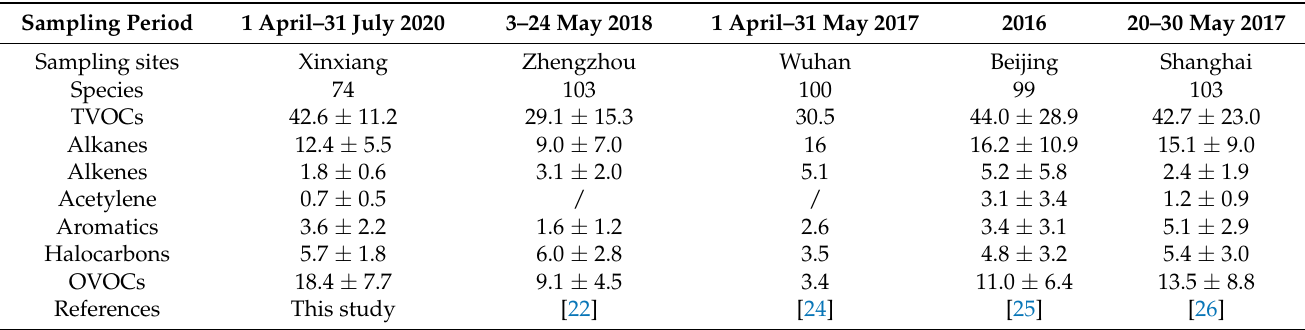
Table 1. Concentrations of VOCs and major VOC groups in Xinxiang and other cities from this study and previous studies (in ppbv).